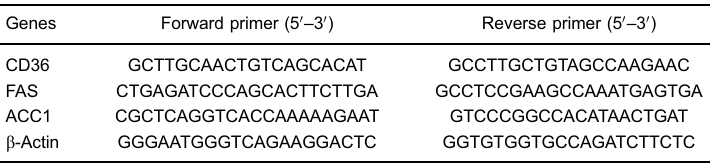
Table 1. The primer sequences used for the reverse transcription-quantitative polymerase chain reaction.